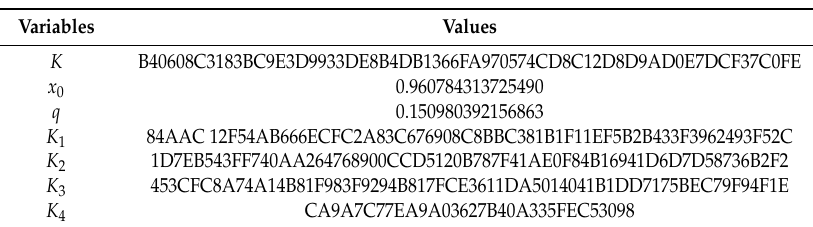
Table 2. Variables and their values.